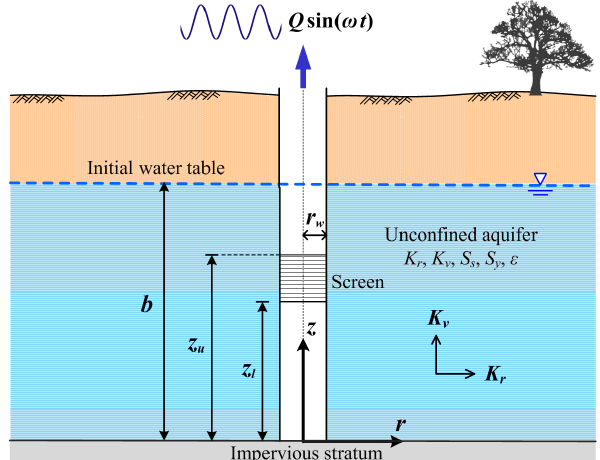
Figure 1. Schematic diagram for oscillatory pumping test at a par- tially screened well of finite radius in an unconfined